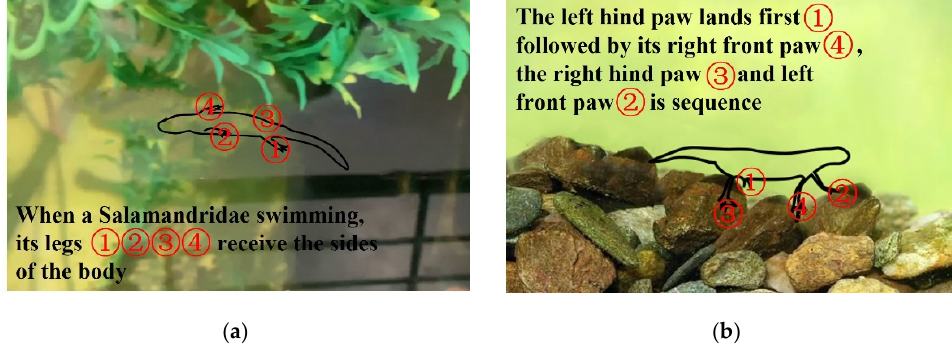
Table 2. The technical specification of the son underwater robot.